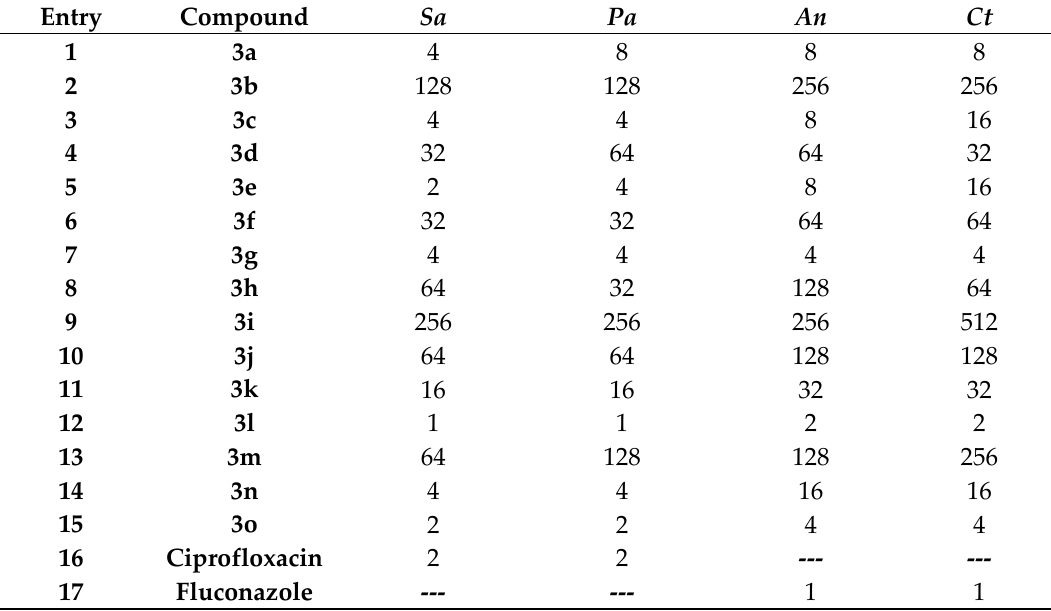
Table 1. Results of the antibacterial and antifungal activities of chalcones